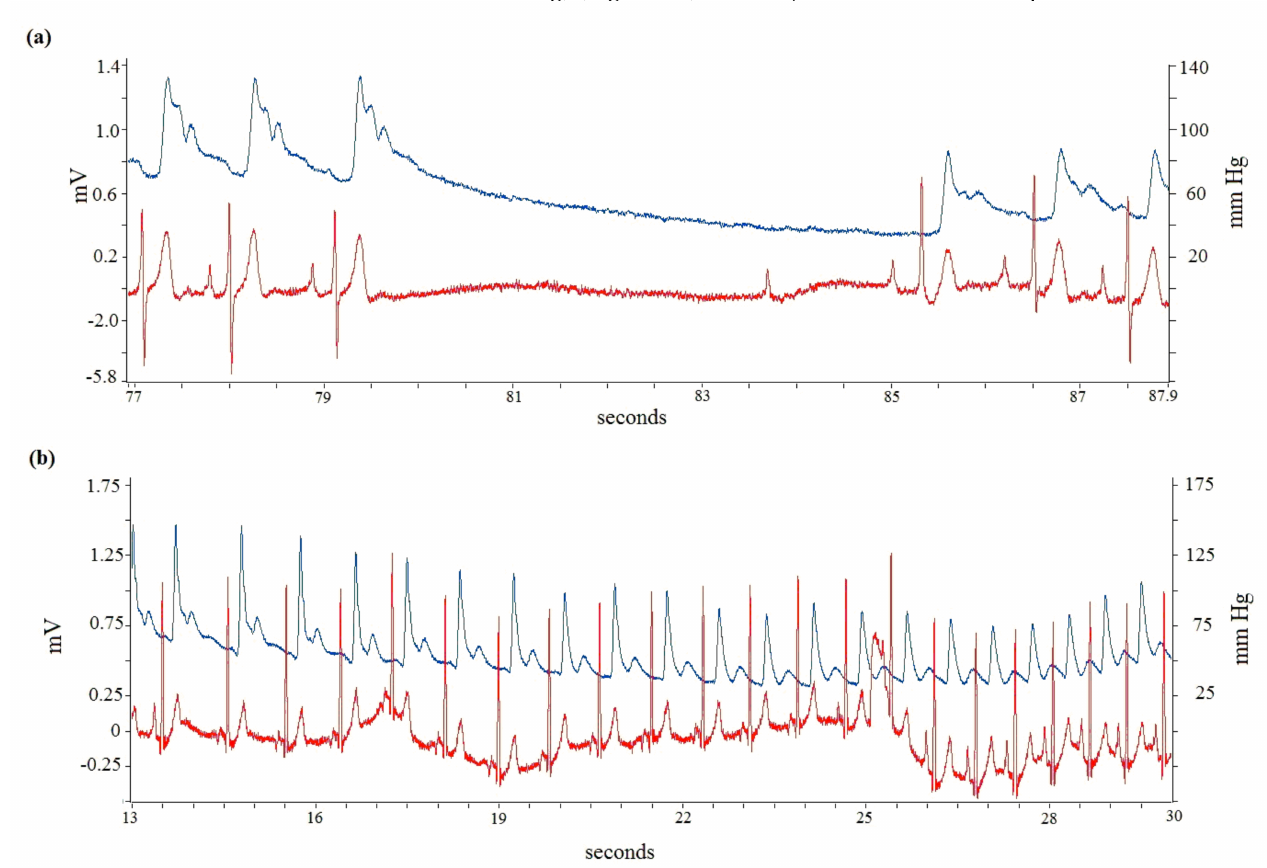
Figure 1. ( a , b ). Representative ECG and systolic blood pressure (SBP) recordings during carotid sinus massage in two patients with carotid sinus hyper sensibility with cardioinhibitory ( a ) and vasodepressive response ( b ). Panel A shows the recording sinus arrest, asystole, recovery of sinus electrical activity with complete atrioventricular block (between 83th and 85th s) and junctional rhythm, at the end (after 87th s) recovery of normal electrical activity and systole. Panel B shows the recording with reduction of blood pressure (from 150/80 to 75/50 mmHg) during carotid sinus massage without